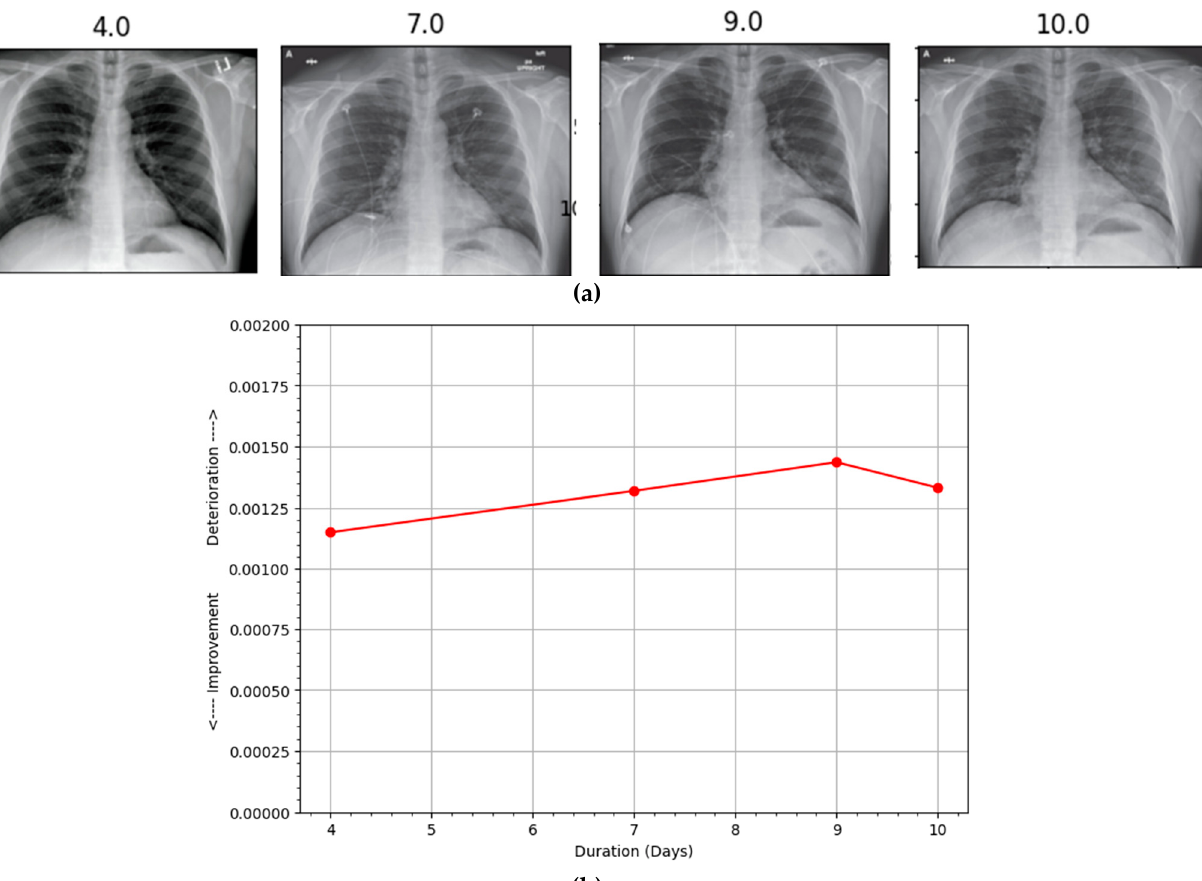
Figure 6. ( a ) Subsequent radiographs belonging to a patient (303) who exhibited improvement as reflected in ( b ) the disease progression profile. The patient was intubated but survived the infection.